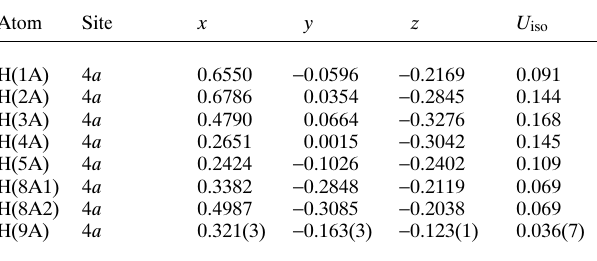
Table 2. Atomic coordinates and displacement parameters (in Å 2 )